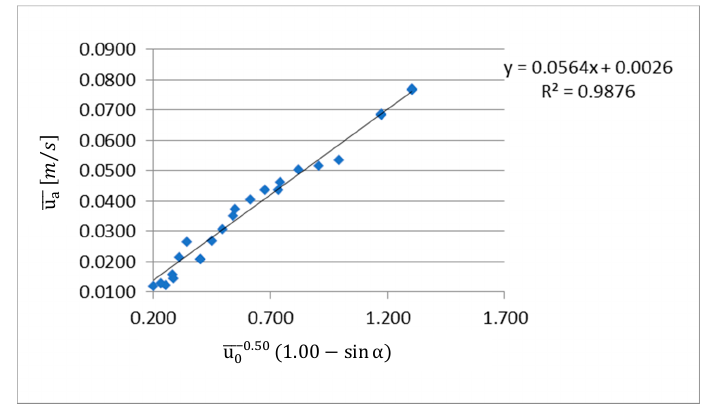
Figure 14. Linear regression average between the velocity at the opening and u 00.50 ( 1.00 − sin α ) .